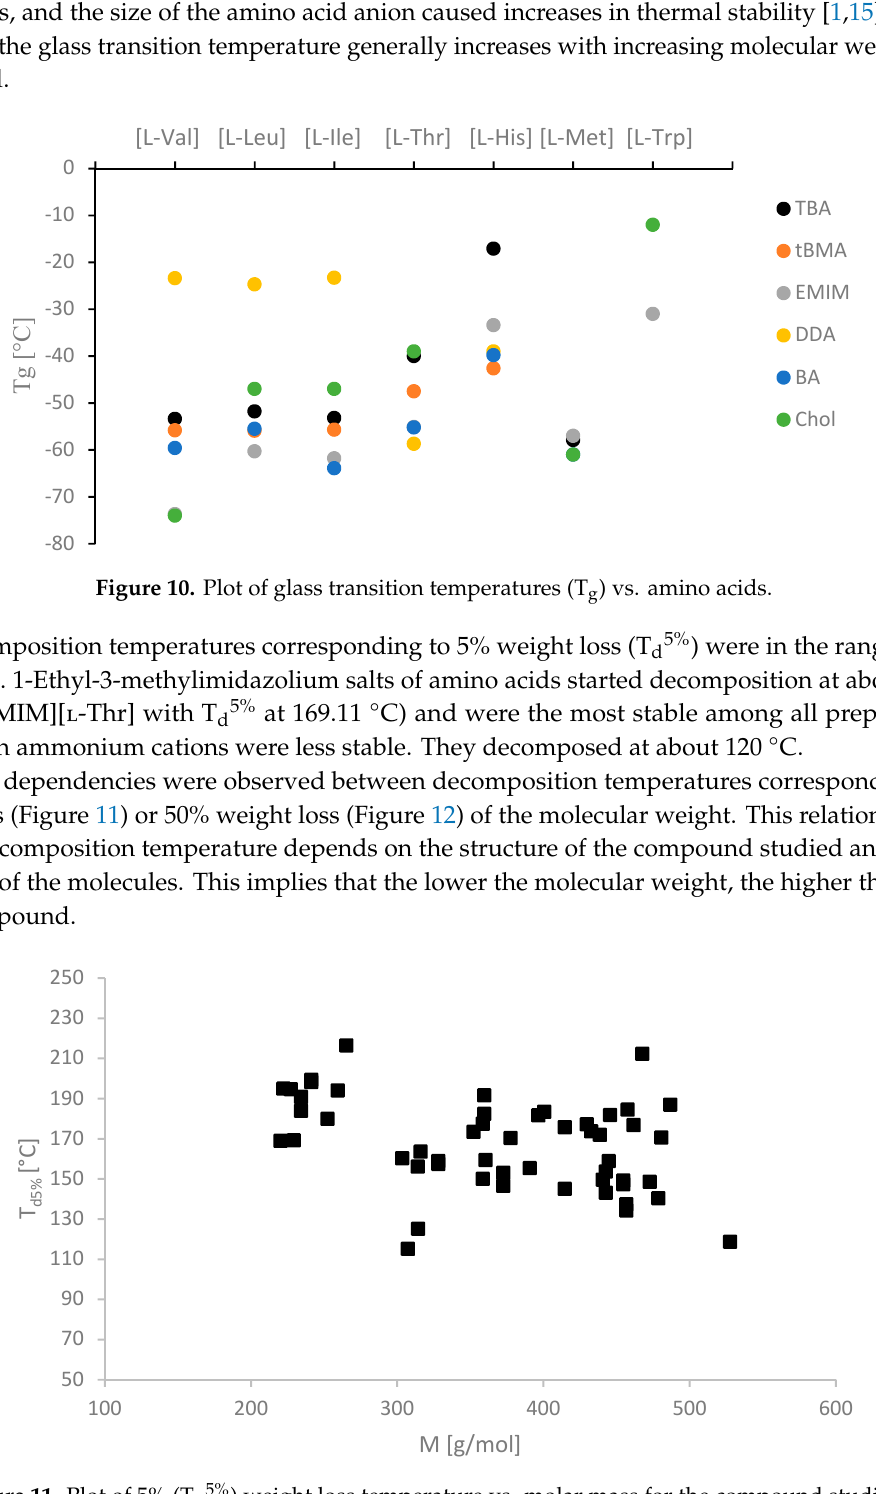
Figure 11. Plot of 5% (T d5% ) weight loss temperature vs. molar mass for the compound studied.